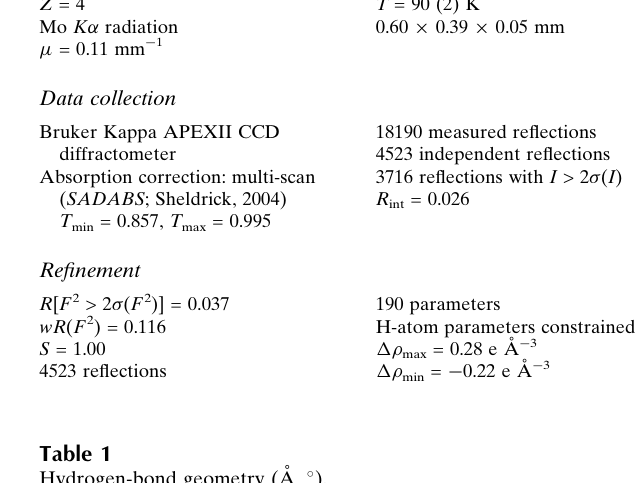
Hydrogen-bond geometry (A˚ , (cid:2)